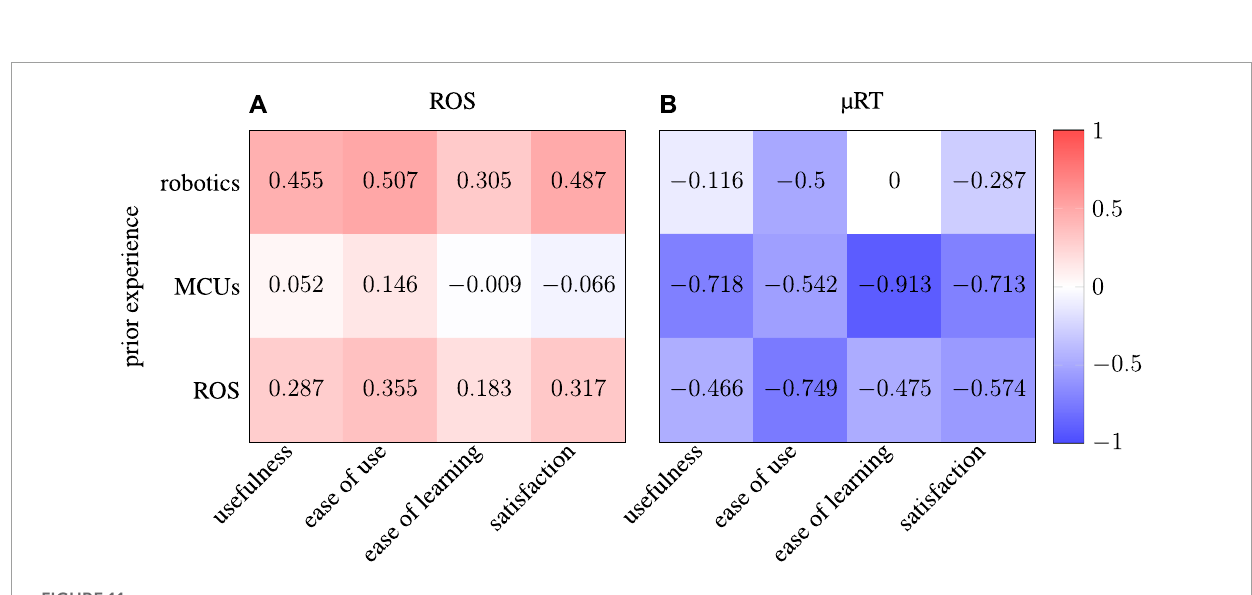
FIGURE 11 Correlation matrices showing the correlation between previous experience in three topics of computer science and the four aspects of the USE questionnaires. The left-hand side (A) depicts the correlation matrix regarding the USE questionnaire of the ROS line-following task (based on 12 data points), whereas the right-hand side (B) relates to µRT (based on six data